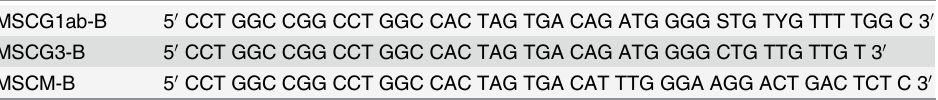
streptavidin in water overnight at 4°C) which was coated overnight with biotinylated CD20 peptide (biotin-SGSGNCDPANPSEKNSLSIQYCGS) for each round and after incubating for 1 hour the immunotube was washed several times with 0.1% (v/v) PBS-T. The bound phage was eluted using 10 μ g/ml Trypsin and re-infected into TG1 cells after they reached an OD of 0.4 Table 6. V H 3 ’ primers for construction of a murine scFv library (pCOMB3xSS). MSCG1ab-B